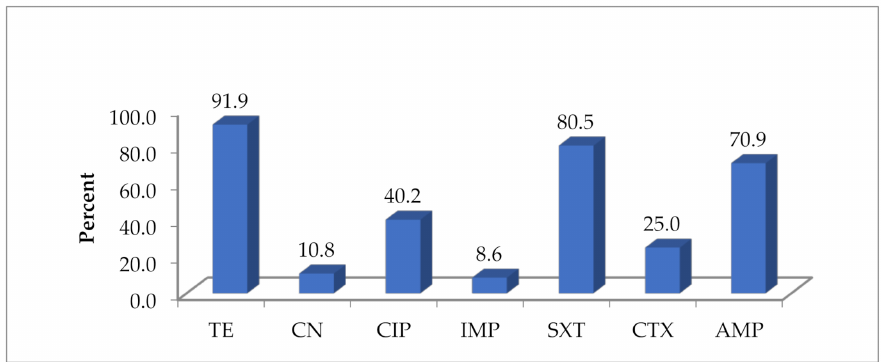
Figure 1. Overall antibiotic resistance pattern of E. coli isolates in five poultry slabs ( n = 212). TE = tetracycline, CN = gentamycin, CIP = ciprofloxacin, IMP = imipenem, SXT = trimethoprim- sulfamethoxazole, CTX = cefotaxime, AMP =